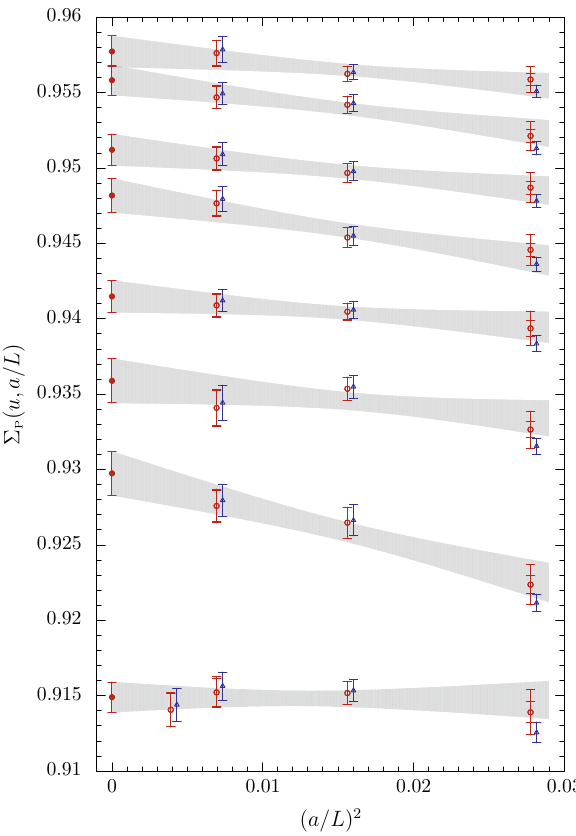
Fig. 1 Continuum extrapolations of (cid:2) u in the high- P at fixed value of energy region. Open blue triangles correspond to (cid:2) P , while open red circles correspond to (cid:2) I ; the latter include the systematic uncertainty P discussed in the text, visible as a double error bar only in the L / a = 6 data. The extrapolations shown (filled red circles and grey bands) are those for (cid:2) I